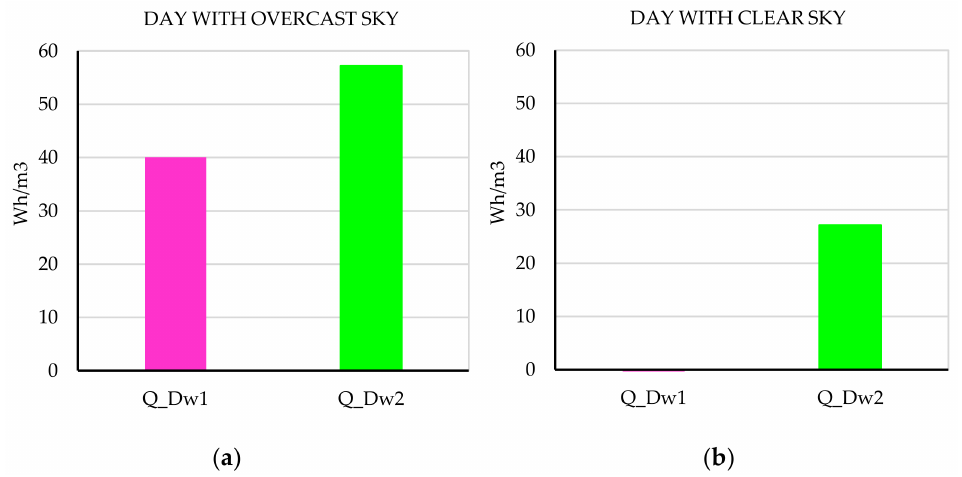
Figure 9. Dw1 (magenta) and Dw2 (green) heating load, ( a ) overcast day, and ( b ) clear sky day. Somewhat paradoxically, despite Dw1 being an older building and having a higher thermal transmission than Dw2, Dw1 had a more balanced thermal performance in the winter, not just on indoor temperature but also on energy consumption. Dw1 showed a suitable configuration between the climatic issues with its building’s design. It had a larger amount of solar radiation largely due to its more southern orientation and its building volumetric heat capacity was sufficient to keep these gains during the day. Thus, Dw1 reached a mean indoor temperature close to or above 20 ◦ C, conversely to